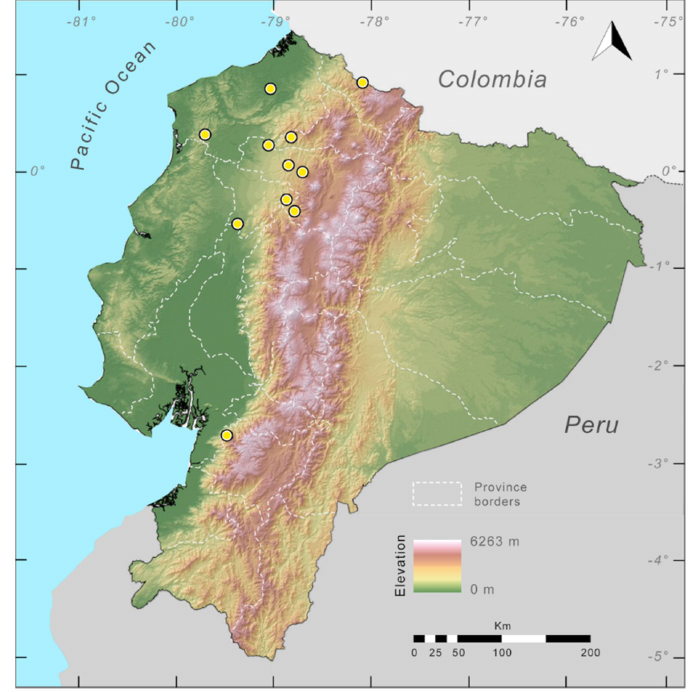
Figure 123. Distribution of populations tentatively assigned to Hyalinobatrachium valerioi in Ecuador (yellow